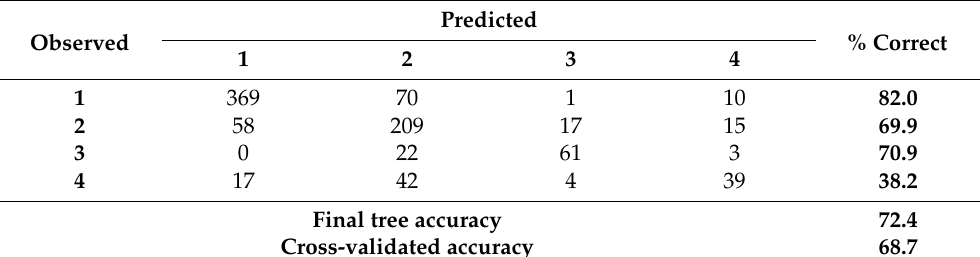
Table 3. Classification accuracy for the final tree model and for the tree models produced in association to the 10-fold cross-validation procedure. FR-specific accuracy values are for the final tree model.